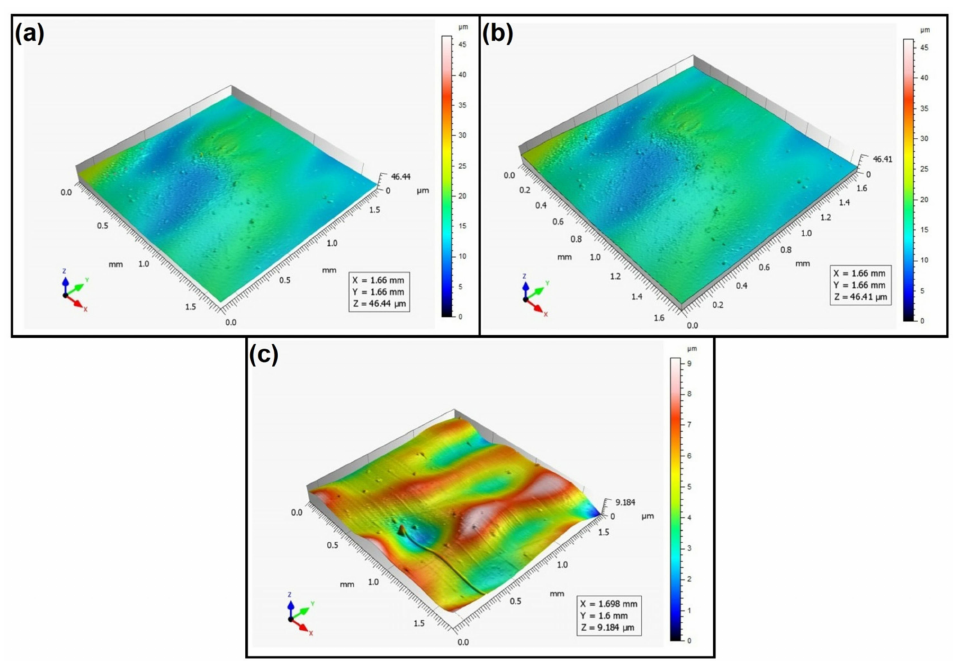
Figure 11. Surface topography of the element 3D printed using PJM technology (Pd = 90 ◦ ). ( a ) Talysurf CCI—without filling non-measured points, ( b ) Talysurf CCI—after filling non-measured points, ( c ) Talysurf PGI